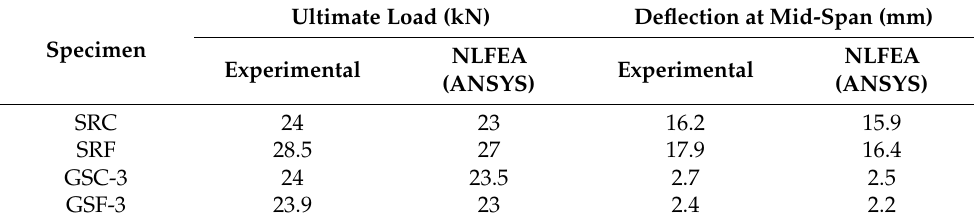
Table 6. Comparison between experimental and numerical